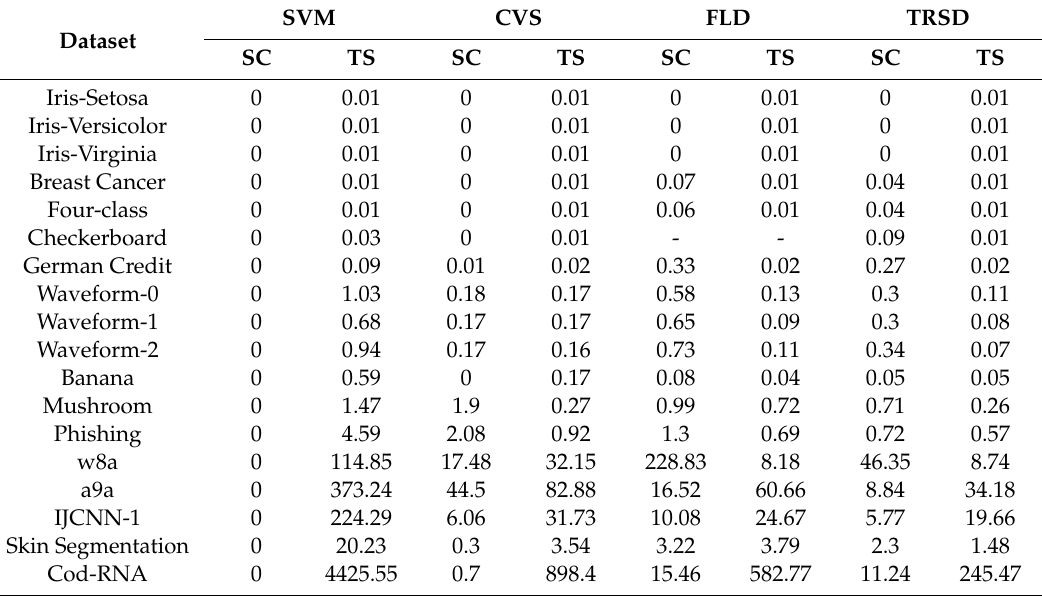
Table 6. Time comparison in detail. SC and TS mean computing time for selecting candidate vectors and training a final SVM model